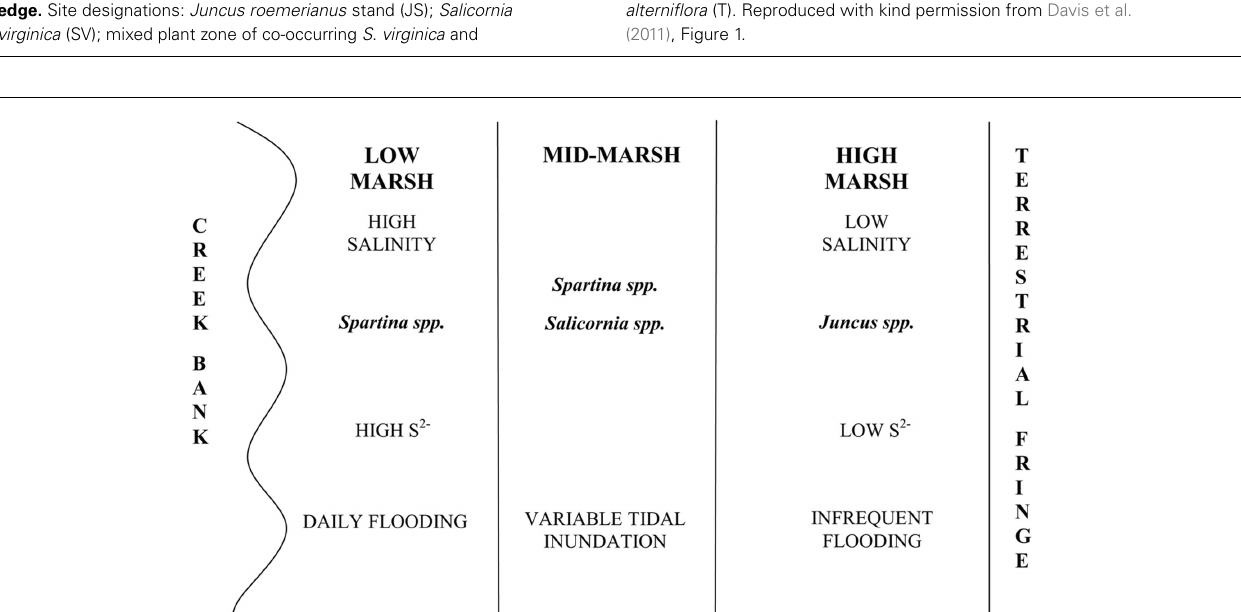
short form Spartina alterniflora (SS); short form S. alterniflora (S); patch of J. roemerianus in the S zone (JP); and tall form S.